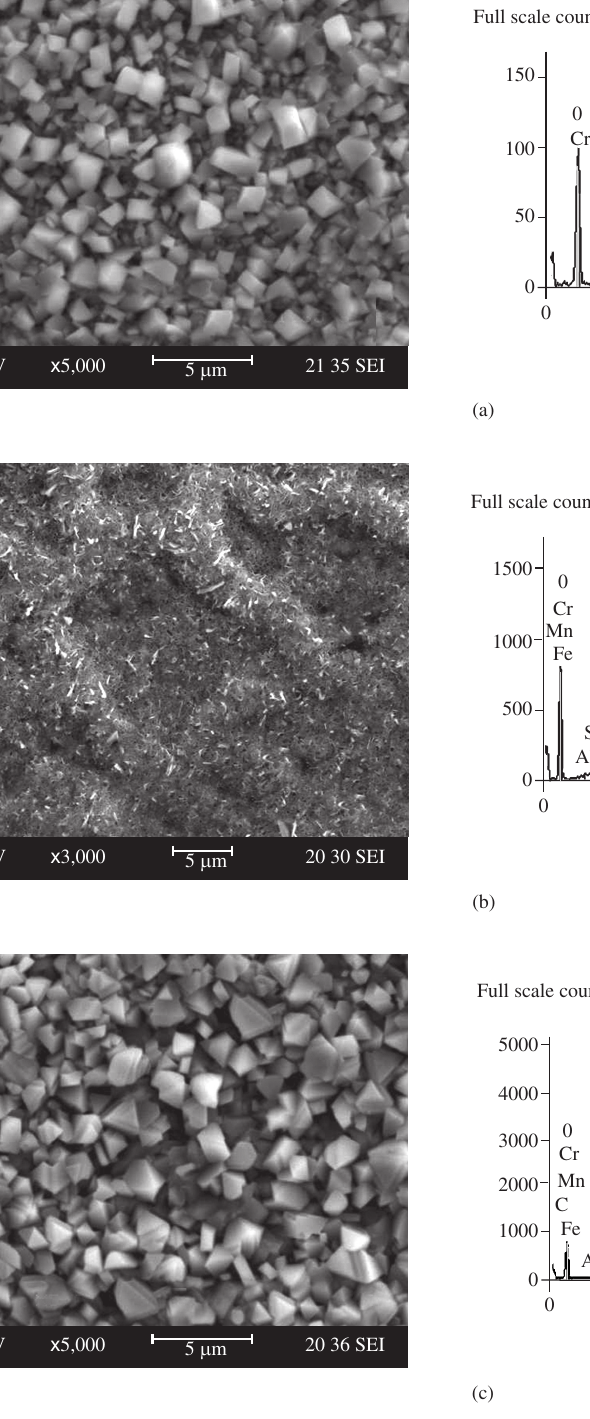
Figure 3. Microstructure and EDS analyses of the oxide films grown on the 430A steel. phase transformation of these steel at about 860 °C, which may be that the microstructure obtained at 850 °C is similar to that obtained responsible for the small variation of the k values between 850 and at 950 °C. On the other hand, the k of the 430E steel depends p p 950 °C. Indeed, at 850 °C, the AISI 430A structure is ferritic and consequently the cation diffusion coefficients in the steel are faster than in an austenitic (or biphased) structure which is obtained at 900 and 950 °C 7 . Consequently, the chromium atom fluxes are greater and the chromia film growth is faster. This is confirmed by the fact